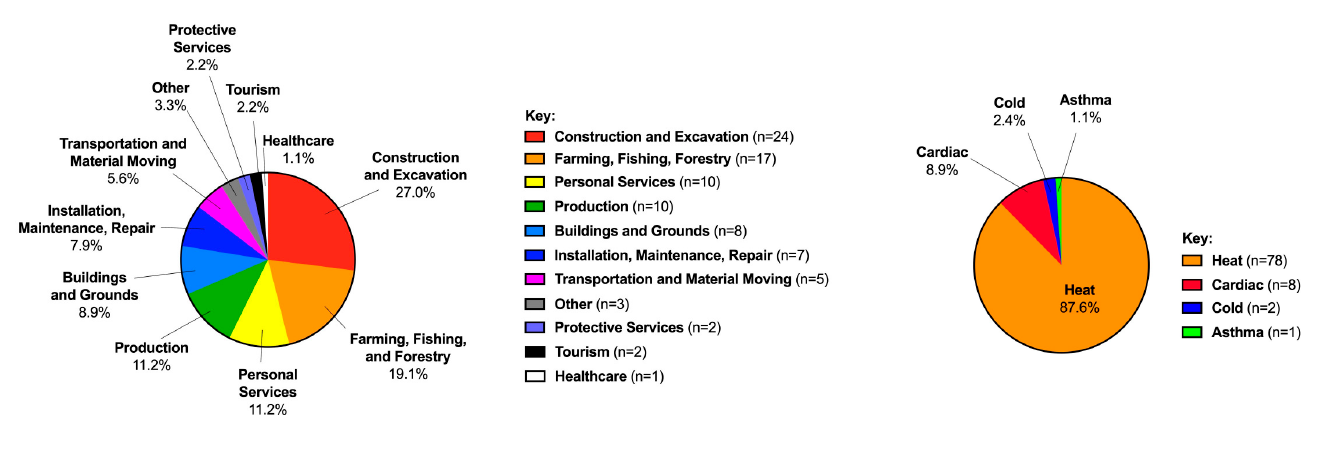
Figure 1. Top causes of exertion-related fatalities across multiple industries. ( A ) Types of causes of exertion-related fatalities; ( B ) industries most affected by ex-ertion-related fatalities.